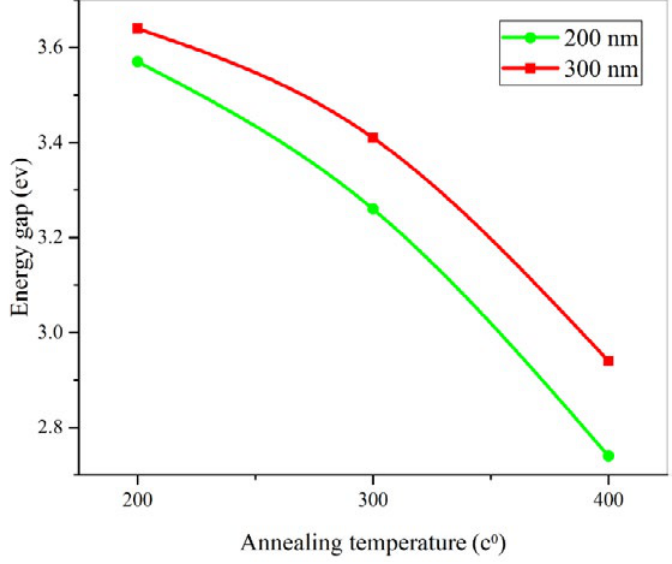
Fig. 10. Energy gap of WO